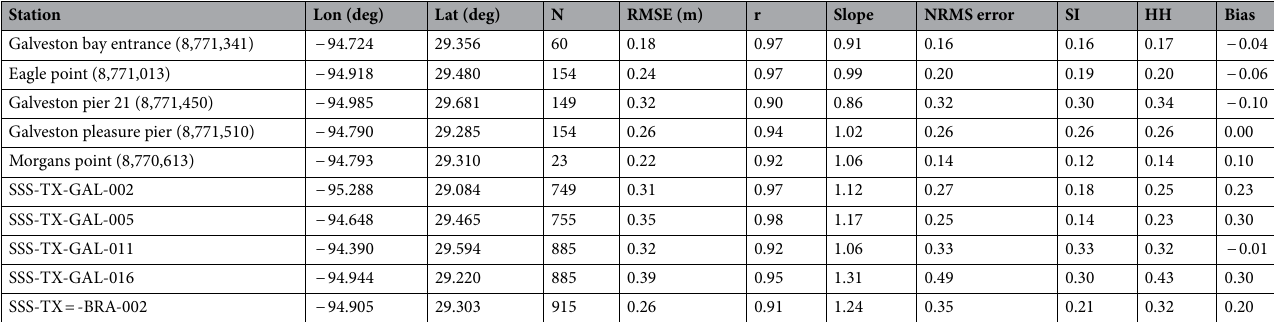
Table 3. Error Statistics for Flood Model. Table shows RMS error (in m), correlation coefficient (r), normalized RMS error (NRMS), regression slope, scatter index (SI), corrected indicator (HH), and bias derived from comparison of simulated water levels and observed water levels at different locations along with the latitude and longitude for each location. N is the number of records used in